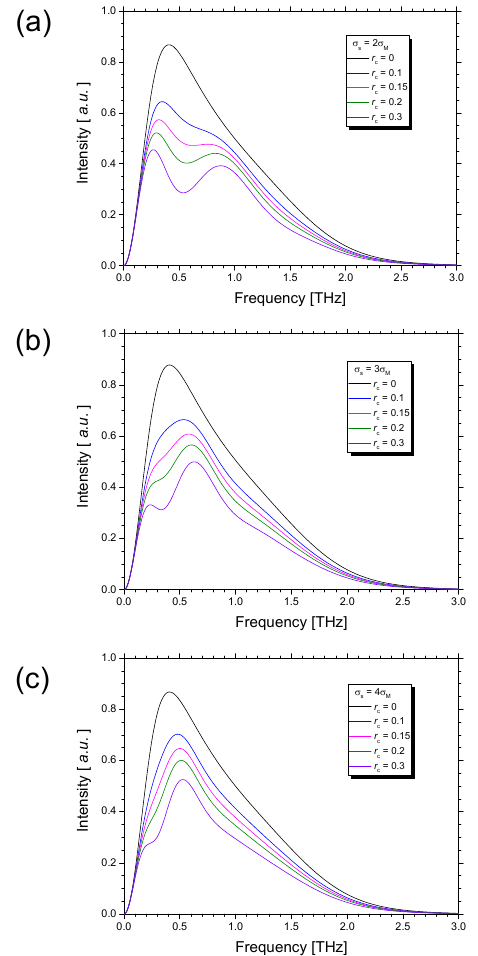
Figure 8. Calculated CER spectra for several r c in the cases of σ S = ( a ) 2 σ M , ( b ) 3 σ M , and ( c ) 4 σ M . Here, σ M is 38.0 μm and d 1 is 2.5.